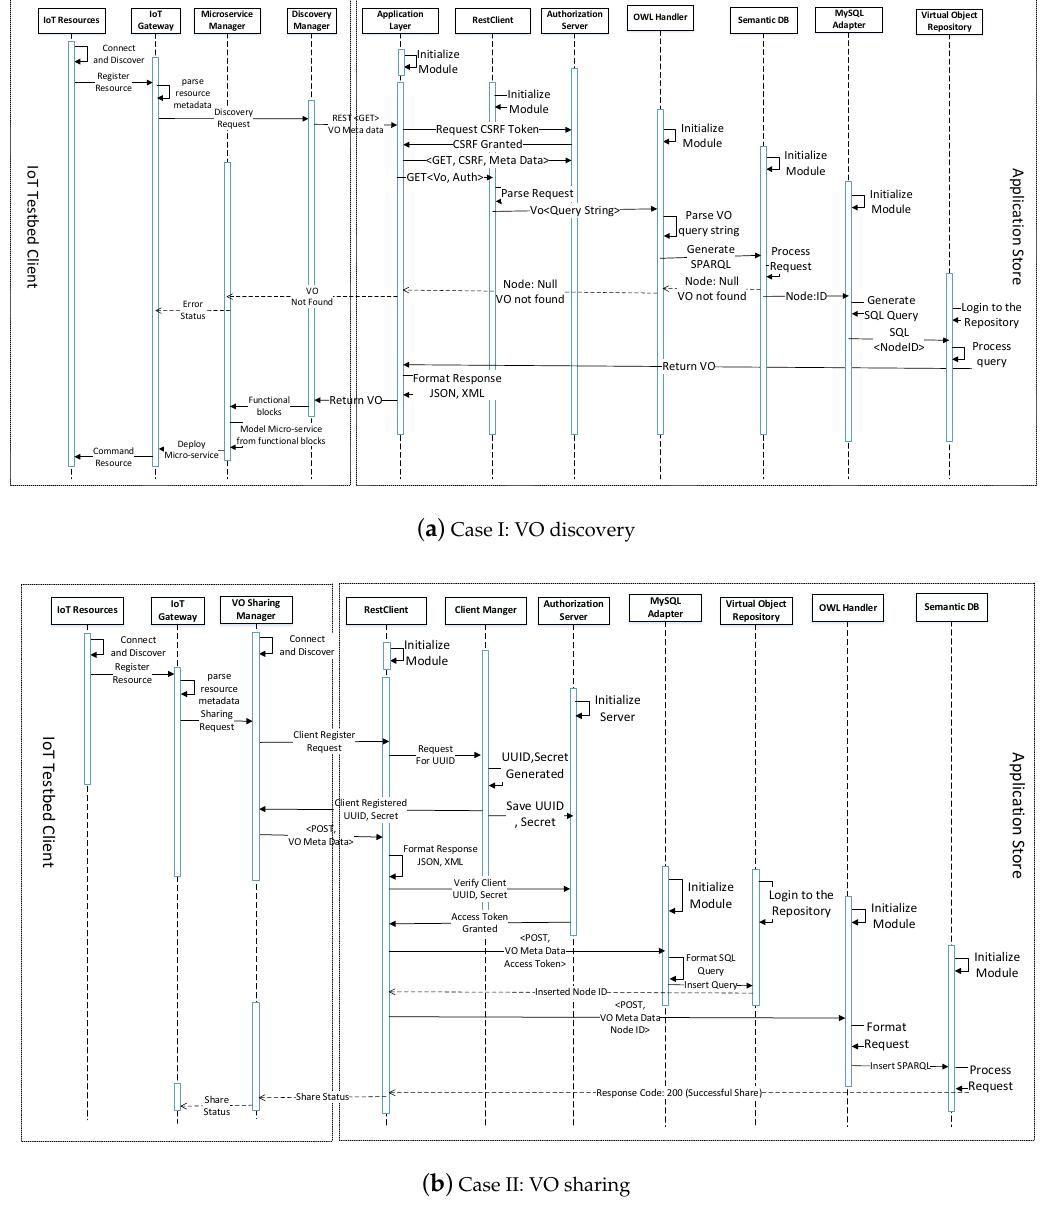
Figure 9. Sequence of operations for the two scenarios, Case I: VO discovery, Case II: VO